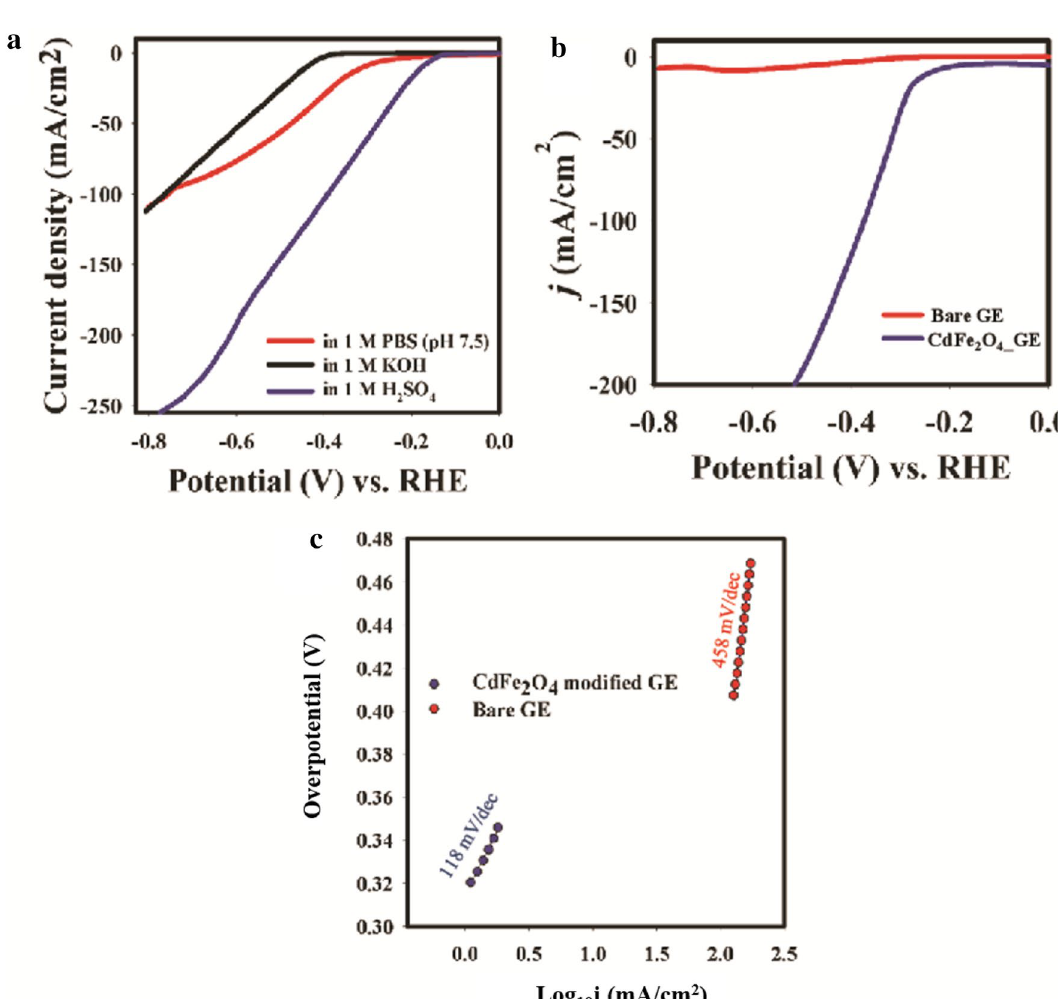
Figure 5. ( a ) effect of supporting electrolyte on HER reaction. ( b ) control study for HER reaction. ( c ) HER Tafel